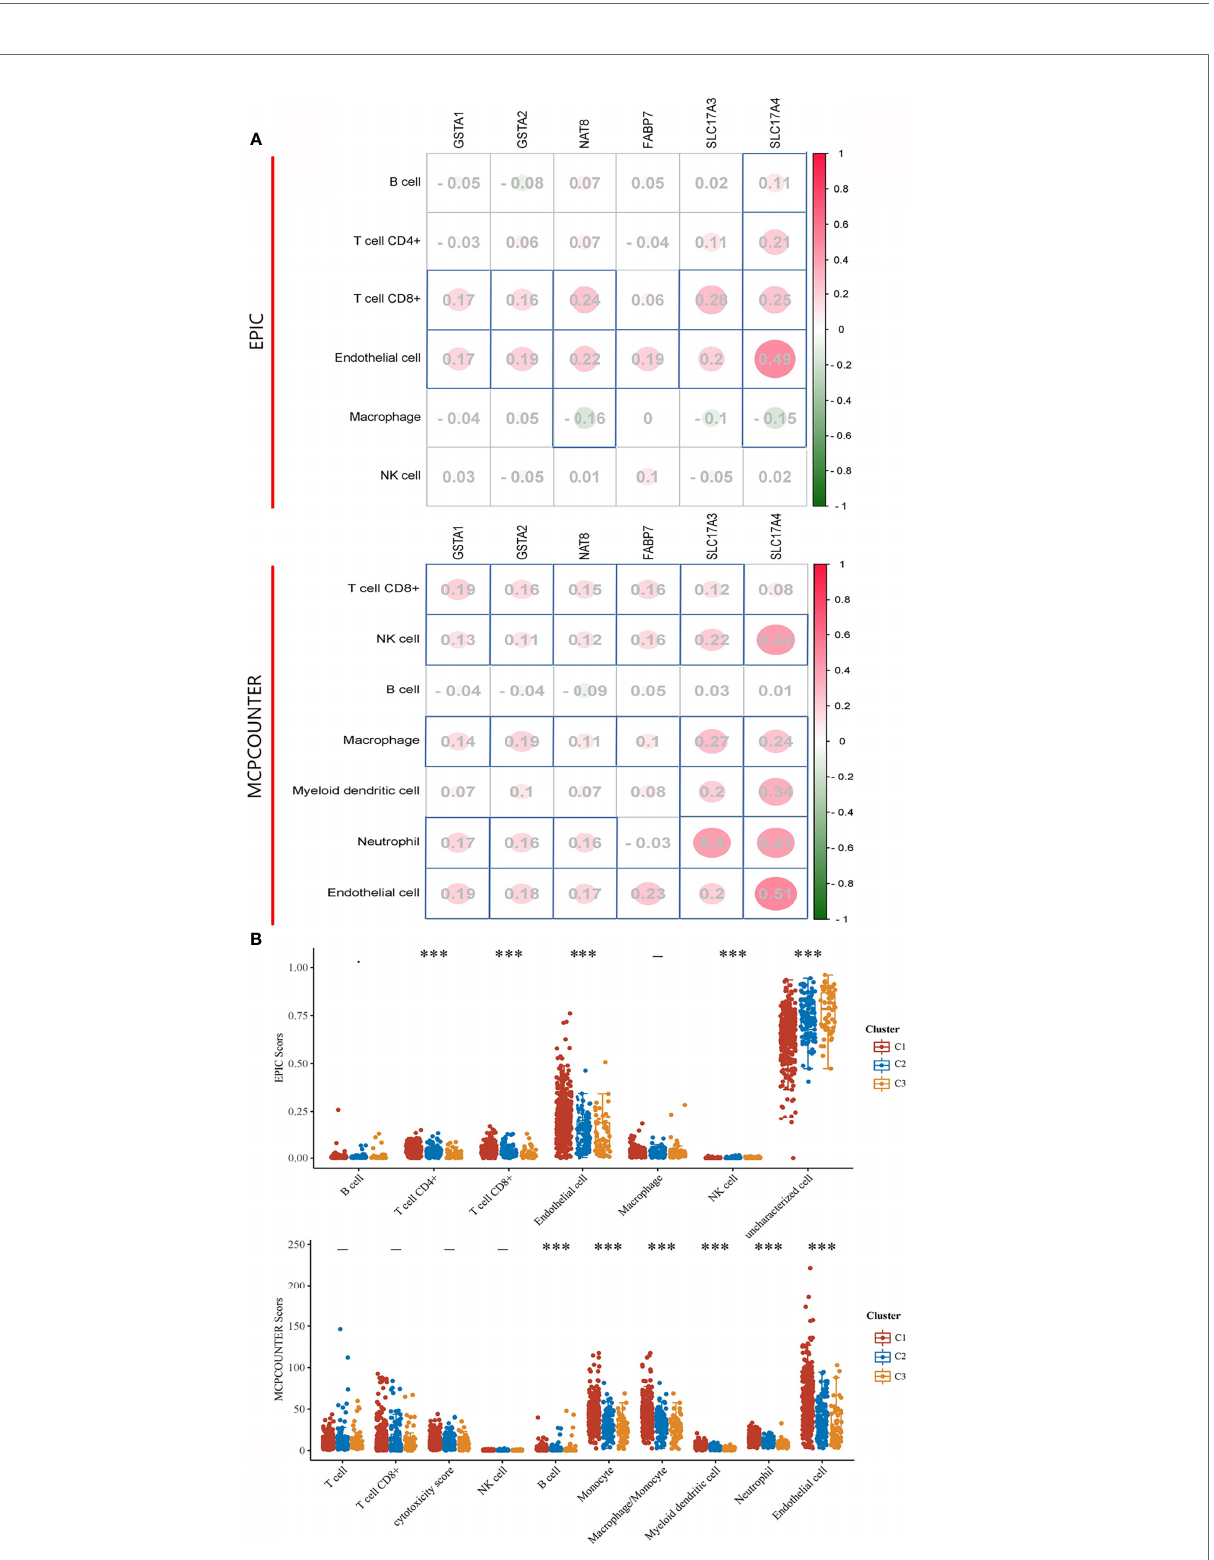
FIGURE 5 | Immune signature of DEGs and three subgroups in ccRCC. (A) The correlations between DEG and immune cells. The corresponding P-values were shown in parenthesis. The left panel shows varieties of immune cells and algorithms. (B) The abundance score of in fi ltrating immune cells across each subgroup. The signi fi cance of the three groups passed by the Kruskal – Wallis test. ***P < 0.001, -: no signi fi